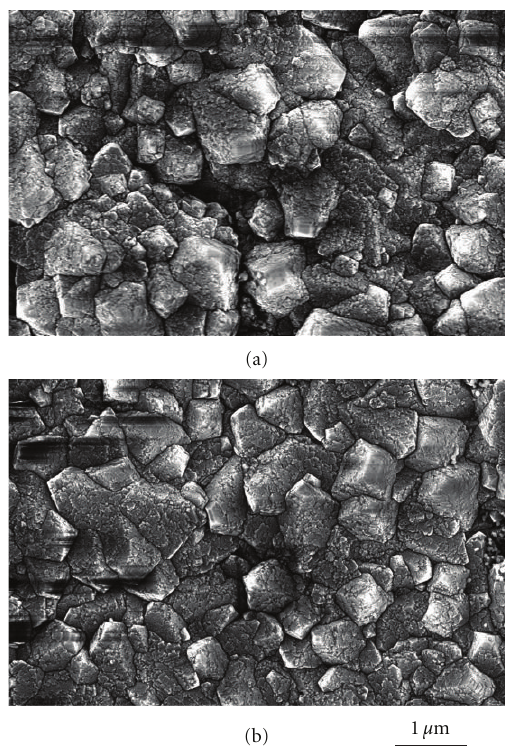
Figure 11: SEM morphology of diamond-coated WC-Co substrate after MP and 1250 W laser processing. Table 2: Wear resistance of the diamond coatings after laser and MP treatments. Sample